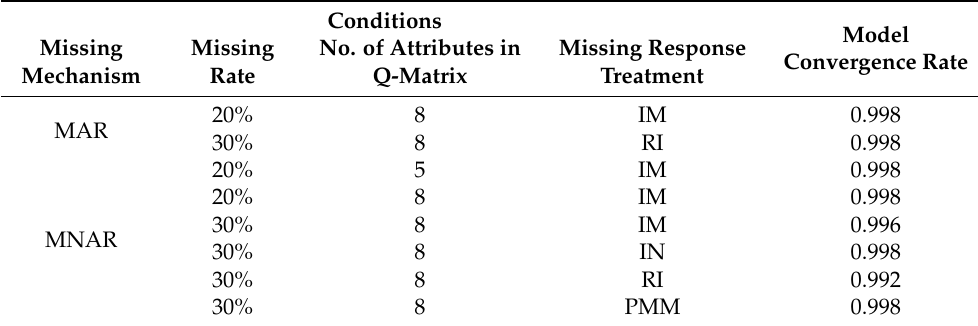
Table 1. Results of model